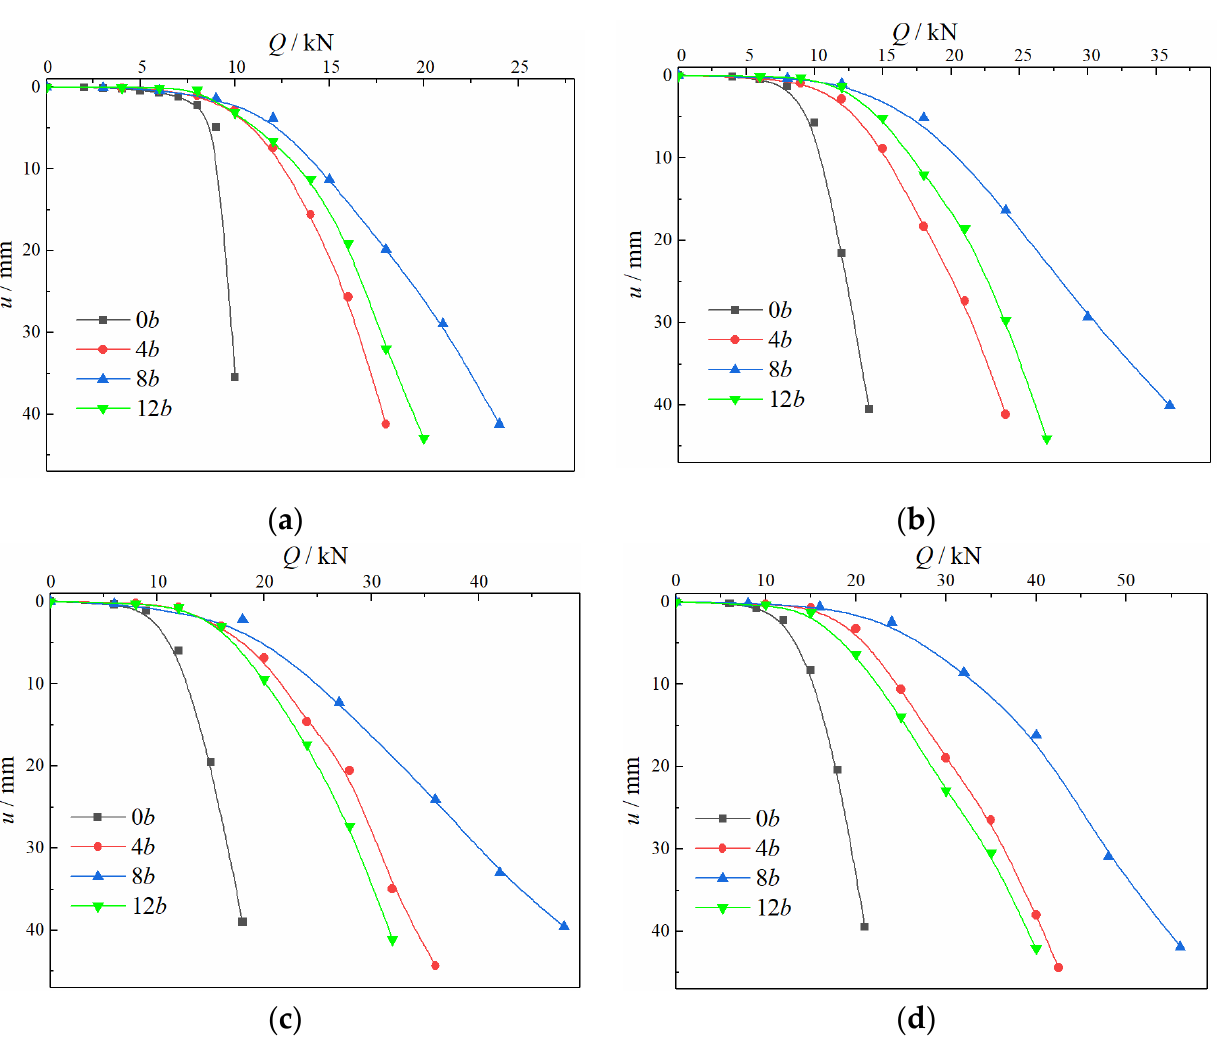
Figure 6. Q – u curves under different conditions. ( a ) 40 kPa, ( b ) 80 kPa, ( c ) 120 kPa, and ( d ) 160 kPa.